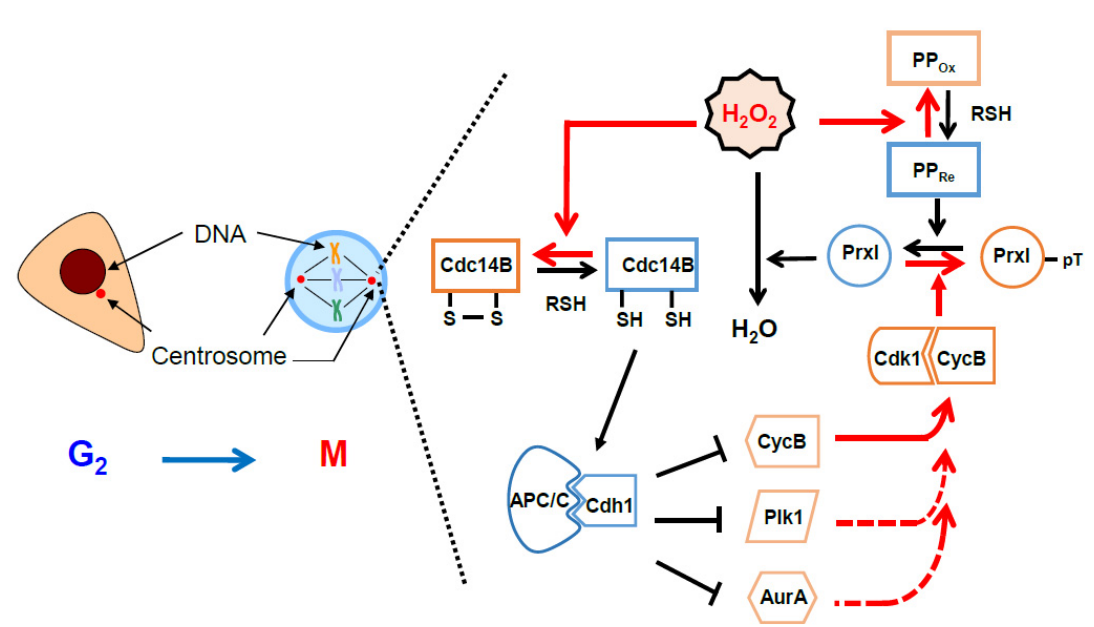
Figure 5. A model illustrating the role of pericentrosomal H 2 O 2 for activation of cell cycle-dependent kinase 1 (Cdk1): Red arrows indicate the direction of the positive feedback reactions resulting from peroxiredoxin I (PrxI) phosphorylation by Cdk1 at the mitotic centrosomes. Black arrows indicate the direction of those resulting from PrxI dephosphorylation. Dashed red arrows indicate multiple positive feedback loops known to activate Cdk1 directly or indirectly. AurA, Aurora A; CycB, cyclin B; Plk1, polo-like kinase1; APC/C, anaphase-promoting complex/cyclosome; PP, protein phosphatase; Cdc14B, cell division cycle 14B. See Section 6 for details.